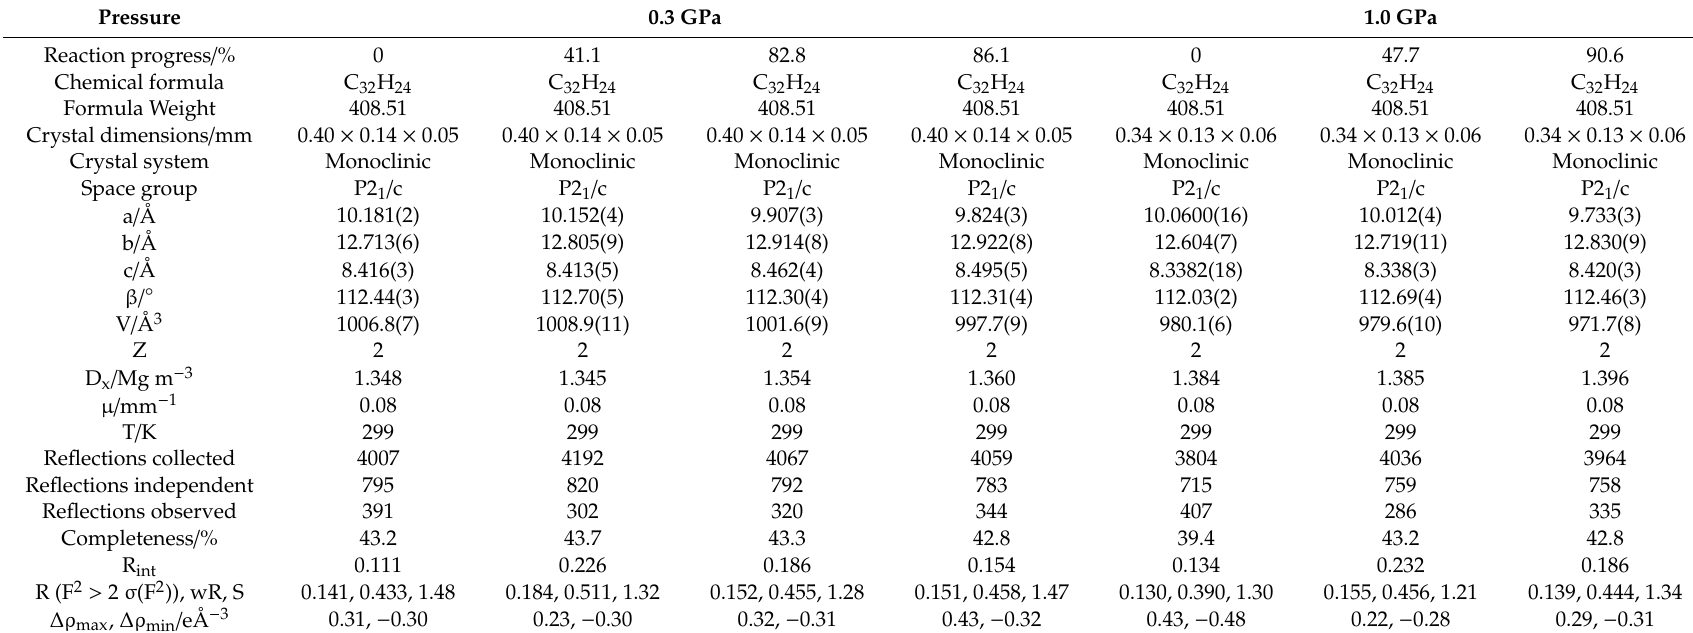
Table 1. The crystallographic and experimental data for ( 1